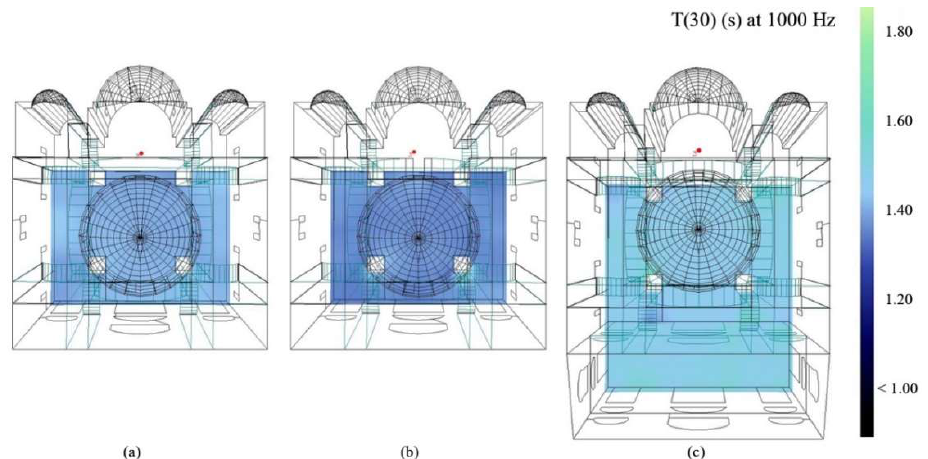
Figure 15. T30 (1000 Hz) distribution maps of ( a ) Bell Church Phase I (without frescoes); ( b ) Bell Church Phase I (with frescoes); ( c ) Bell Church Phase II. There is a fairly uniform distribution of the T30 values over the entire floor of the church.